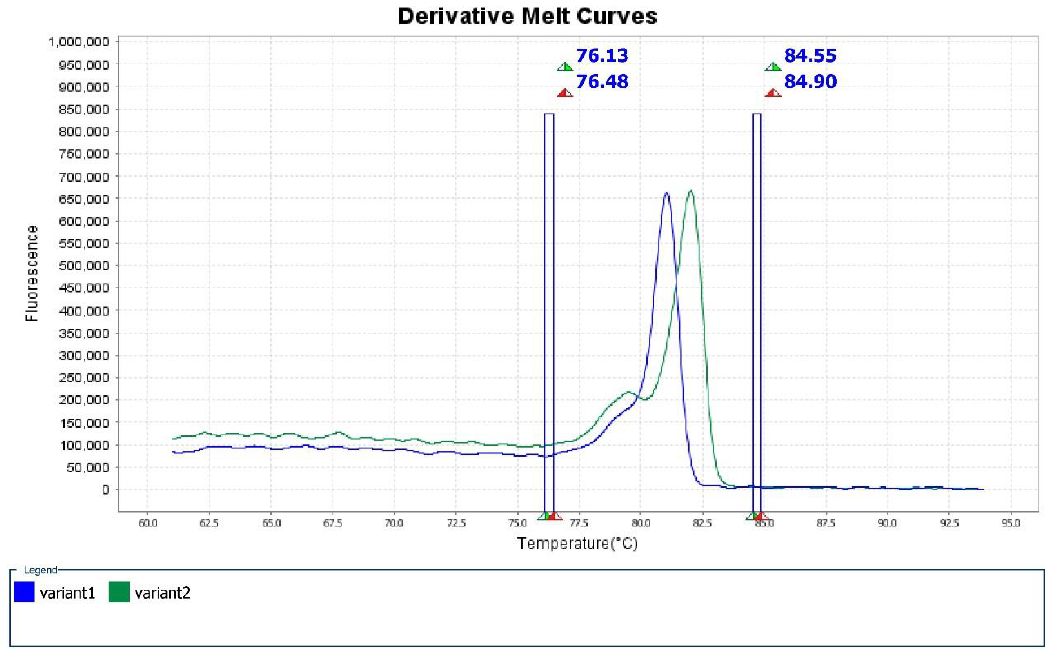
Figure 1. Derivative melt curves of OXA-48 (blue) and OXA-232/OXA-181 (green). The Tm values for variant 1 and variant 2 were 81.1 ± 0.2 °C and 82.1 ± 0.2 °C respectively.